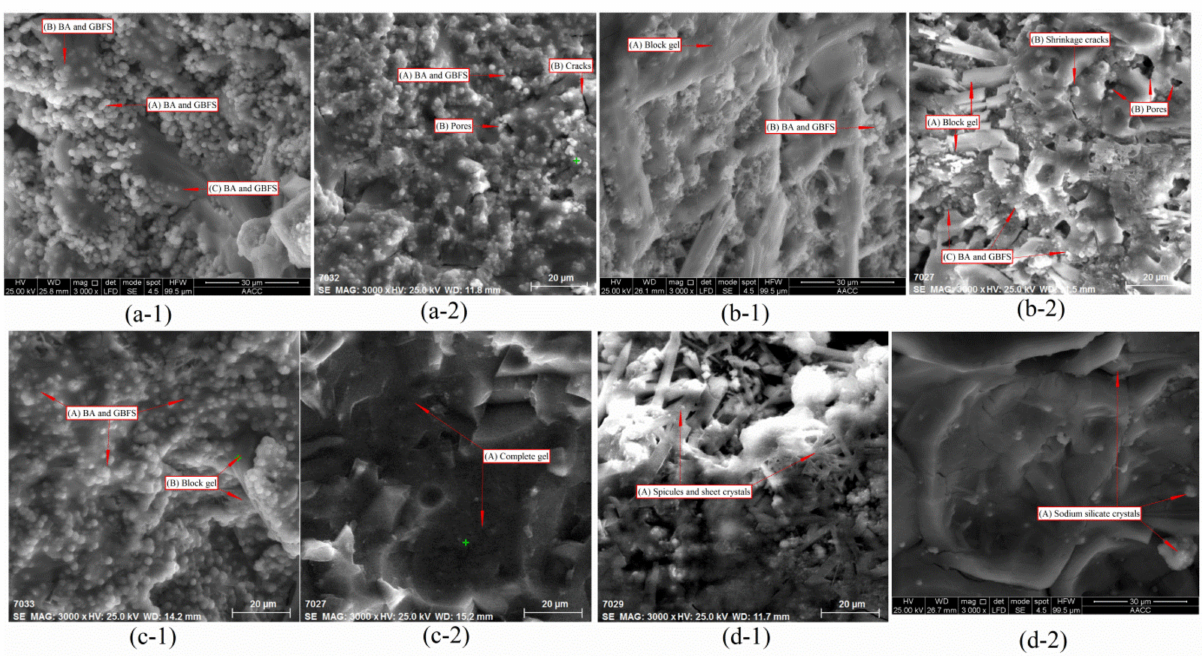
Figure 3. SEM (Scanning electron microscopy) analysis of paste samples A-3, A-5, A-8, and A-9; ( a-1 , b-1 , c-1 , d-1 ) 3 h after preparation of samples A-3 A-5, A-8, and A-9; ( a-2 , b-2 , c-2 , d-2 ) 28 d after preparation of samples A-3 A-5, A-8, and